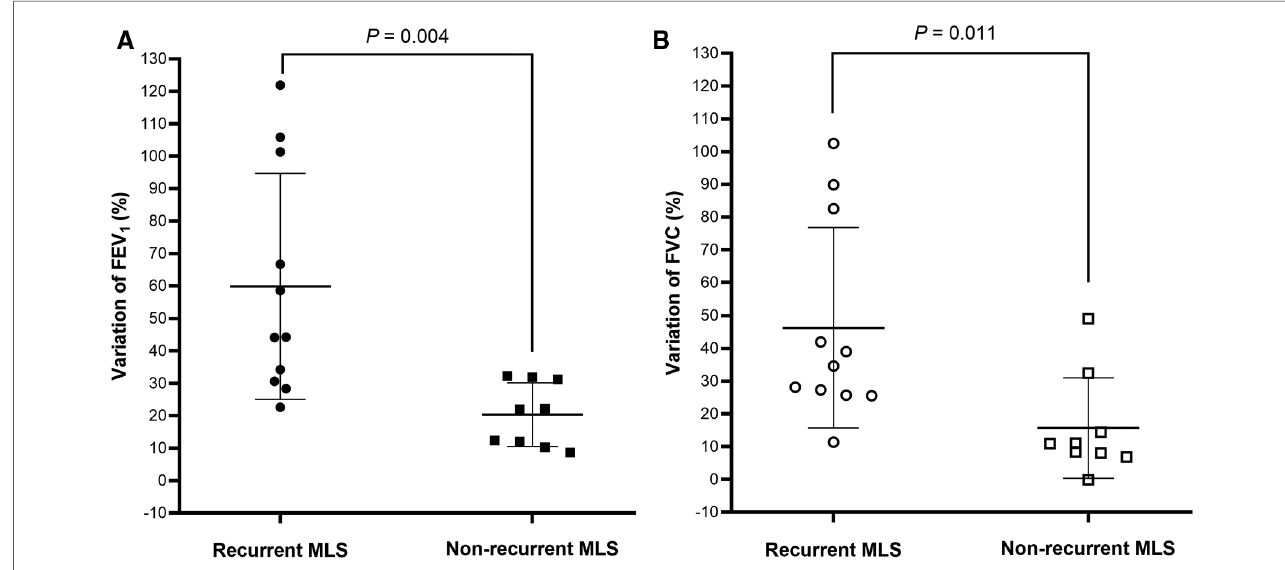
FIGURE 1 FEV 1 ( A ) and FVC ( B ) variations between acute and stable stages were plotted for children with asthma with recurrent MLS vs. those with non-recurrent MLS. Bar charts represented mean±standard deviation. FEV 1 : forced expiratory volume in 1 s; FVC: forced vital capacity; MLS: middle lobe